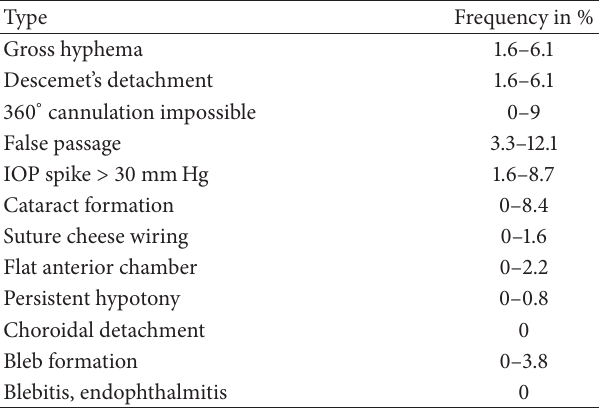
Table 9: Intra- and postoperative complications of